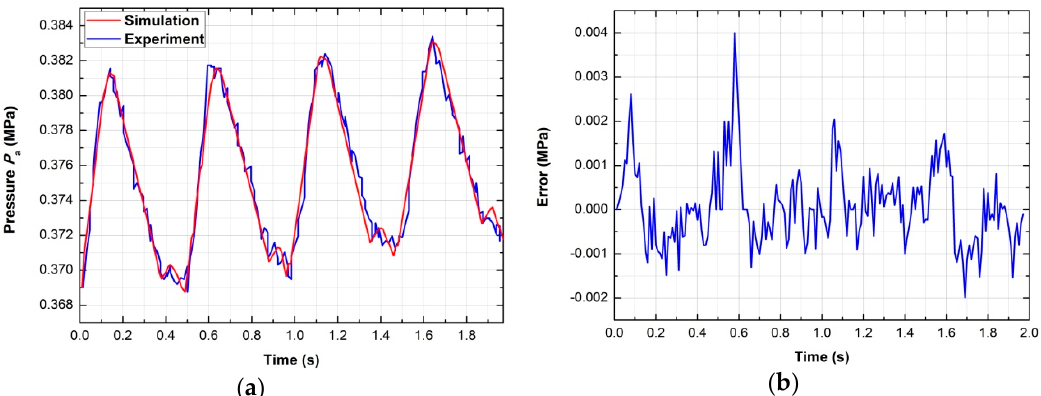
Figure 25. Pressure curve of chamber a and its error curve: ( a ) Pressure curve; ( b ) Error.